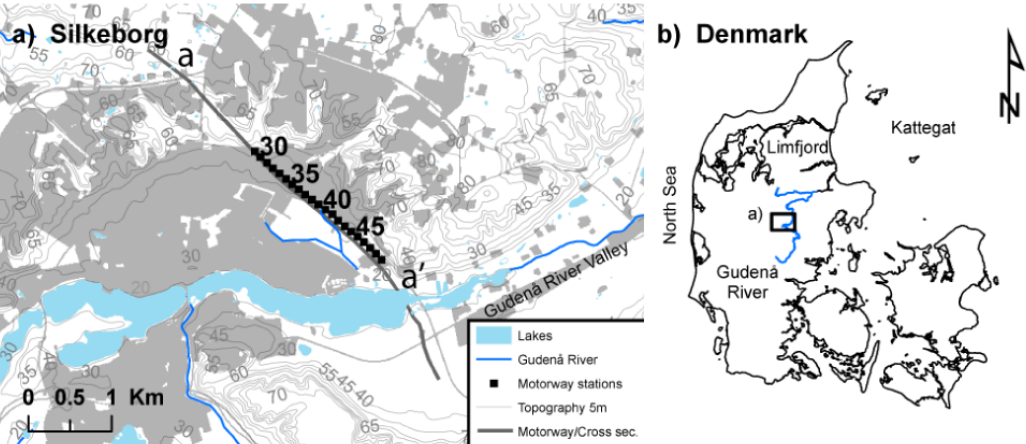
Fig. 1. Location of Silkeborg in Denmark (right) and the new motorway (left). (a) The motorway stretch where construction will be below present ground level with a road surface around 6m below surface. Zones are used for groundwater head analyses (Motorway stations). The grey shaded polygons indicate paved ares. A geological cross section along the motorway from “a–a 0 ” is shown in Fig. 2. (b) Denmark, and location of Silkeborg and the Guden˚a River. “a” indicated focus area shown to the